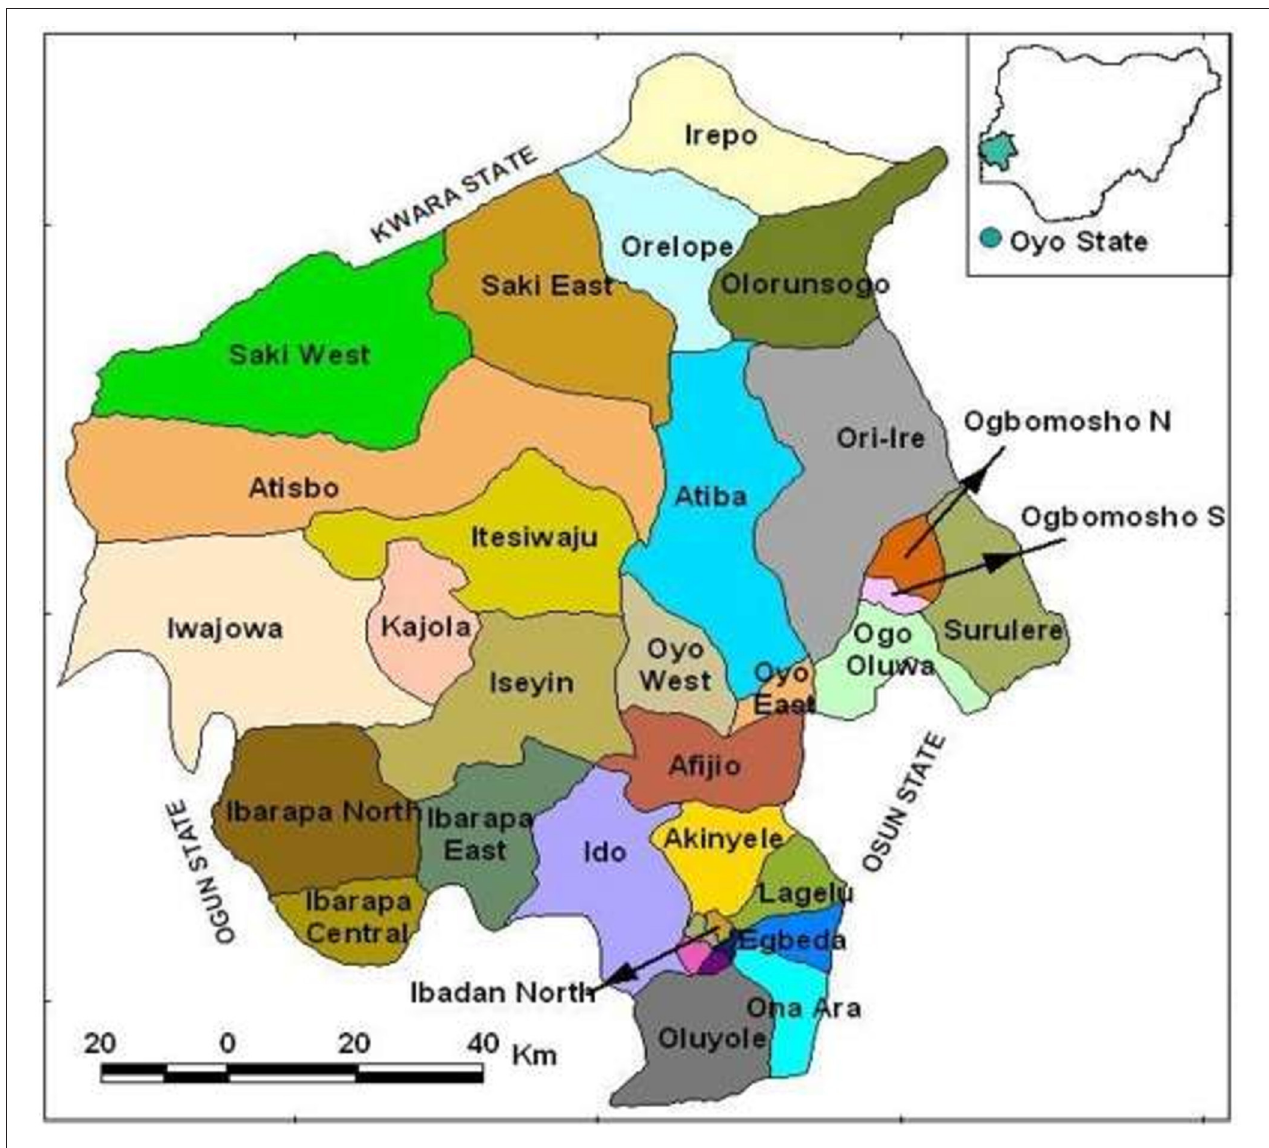
FIGURE 1 | Map of Oyo State,